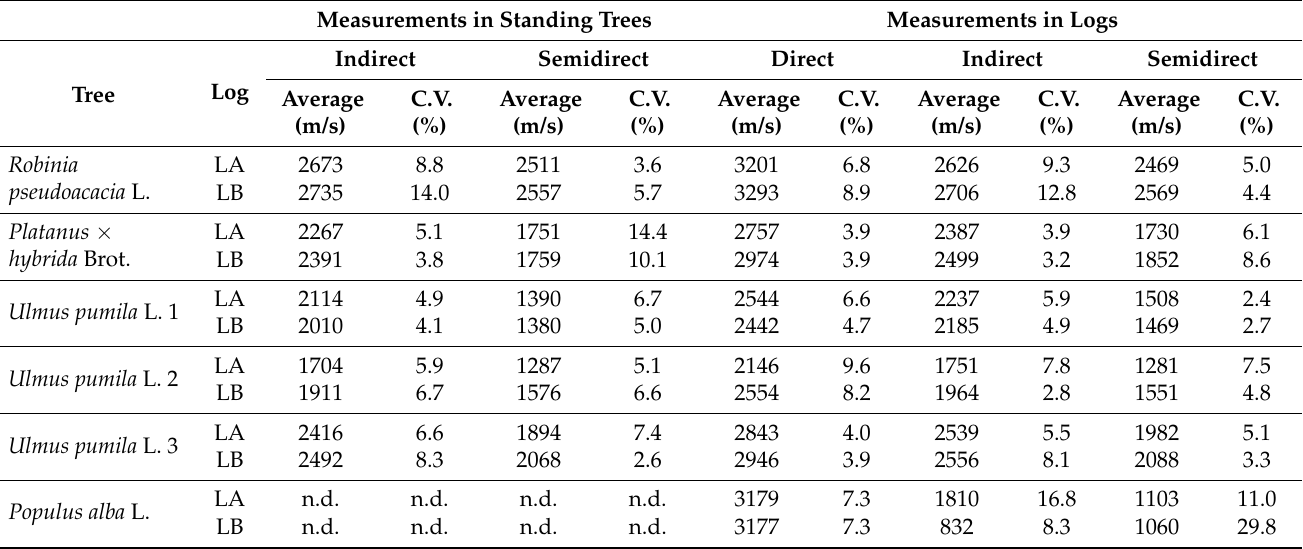
Table 3. Longitudinal velocities with Microsecond Timer and coefficients of variation. Measurements in Standing Trees